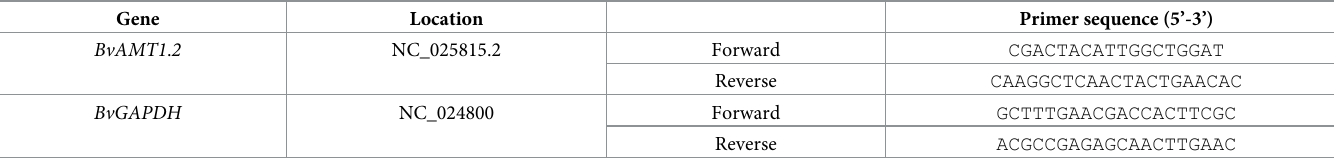
Table 1. qRT-PCR primer sequences.